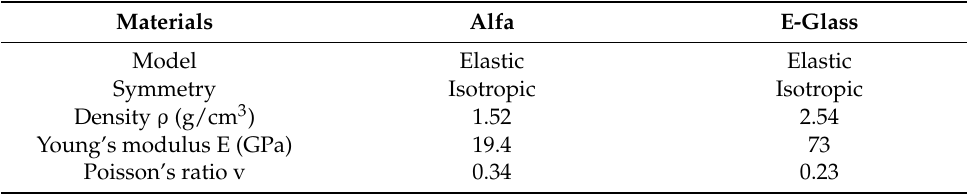
Table 5. Mechanical properties of isotropic